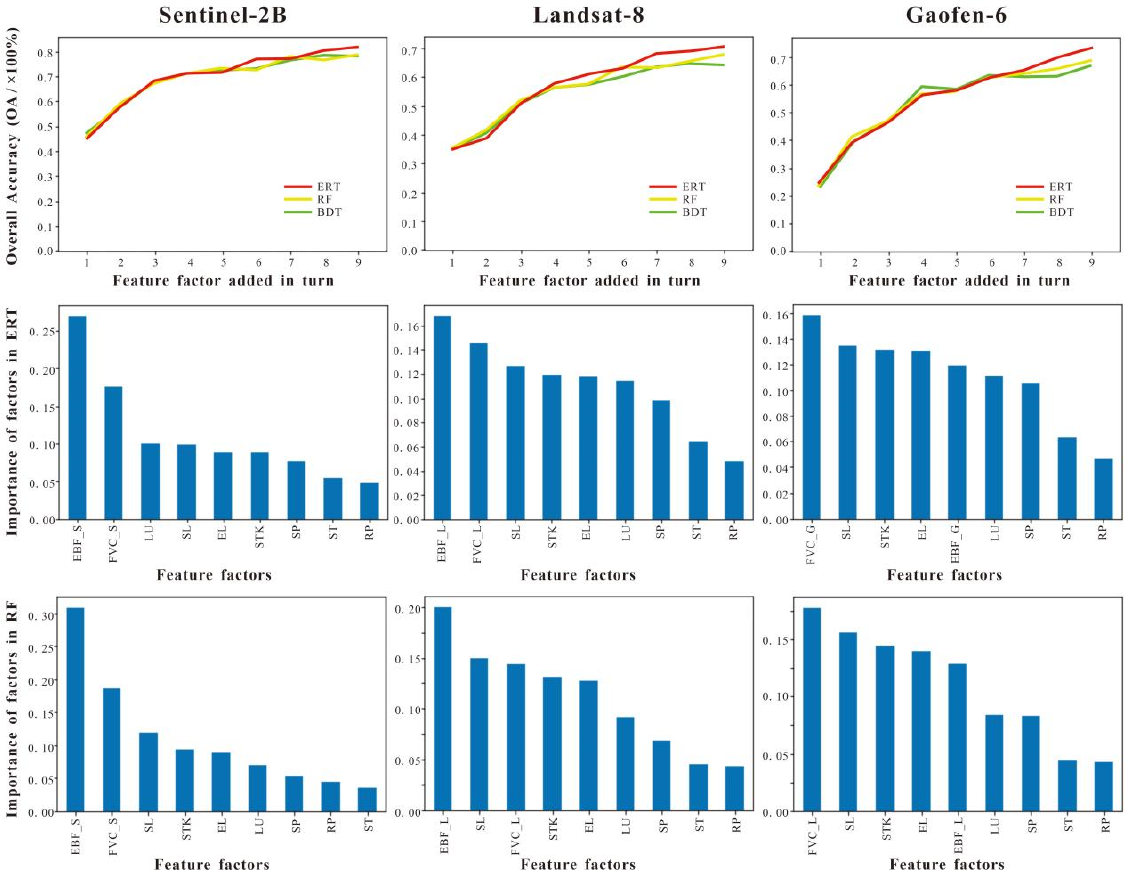
Figure 5. The importance of factor and its relationship with classification accuracy (“S”, “L”, and “G” represent three types of images of Sentinel-2B, Landsat-8, and Gaofen-6. Since the BDT model cannot determine the importance of factors, it adds feature factors in turn according to the addition order of the ERT model).